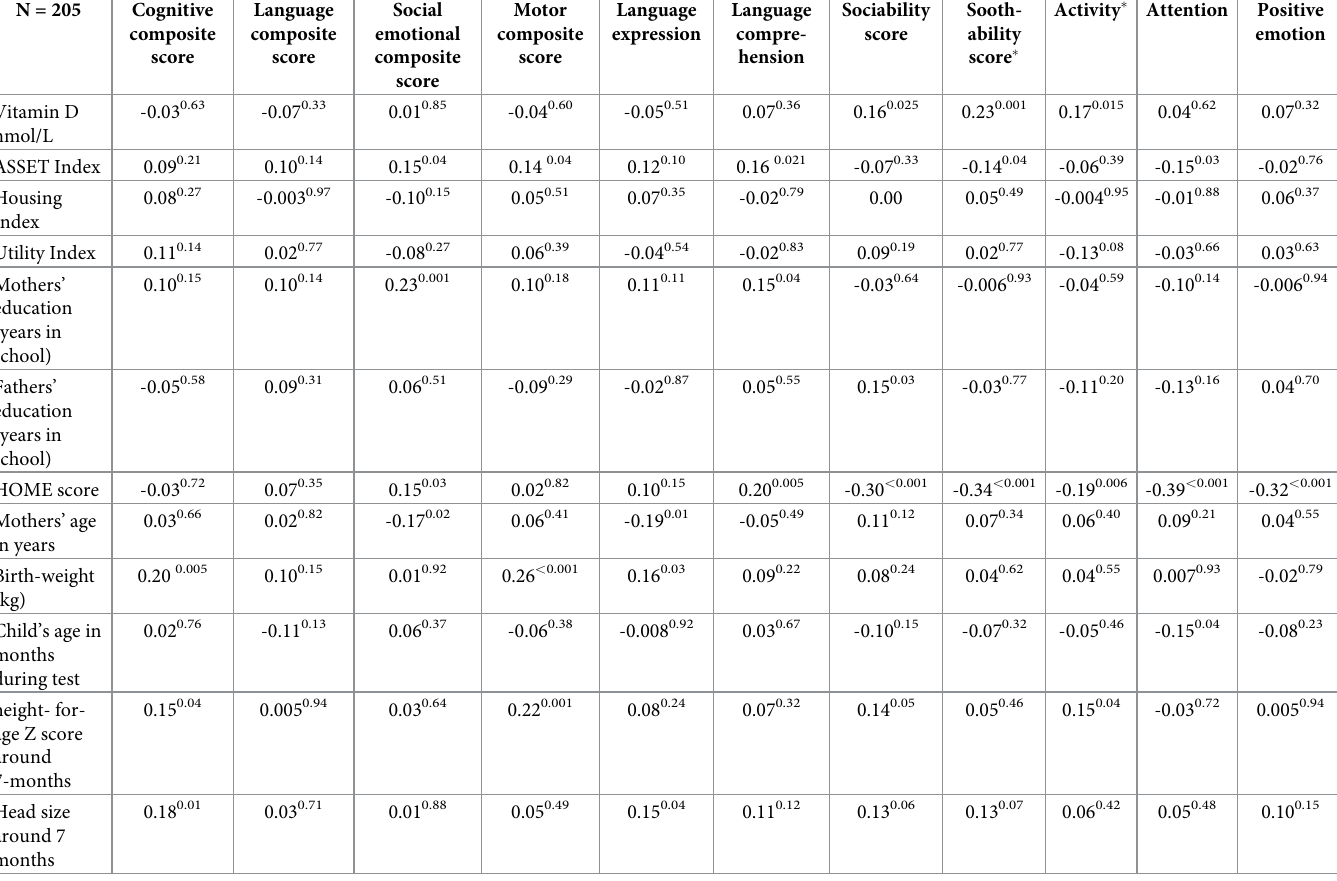
Bi-variate (Spearman’s) correlation, HOME = Home observation of measuring environment; BMI = Body mass index 1 Values are in correlation co-efficient with p-values in superscript � Values are log 10 transformed for mild positive skeweness